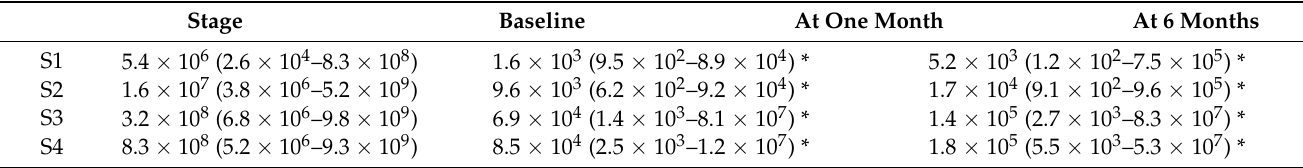
Table 4. Total bacterial load at baseline and at after treatment (one month and six months) in the PDT group.